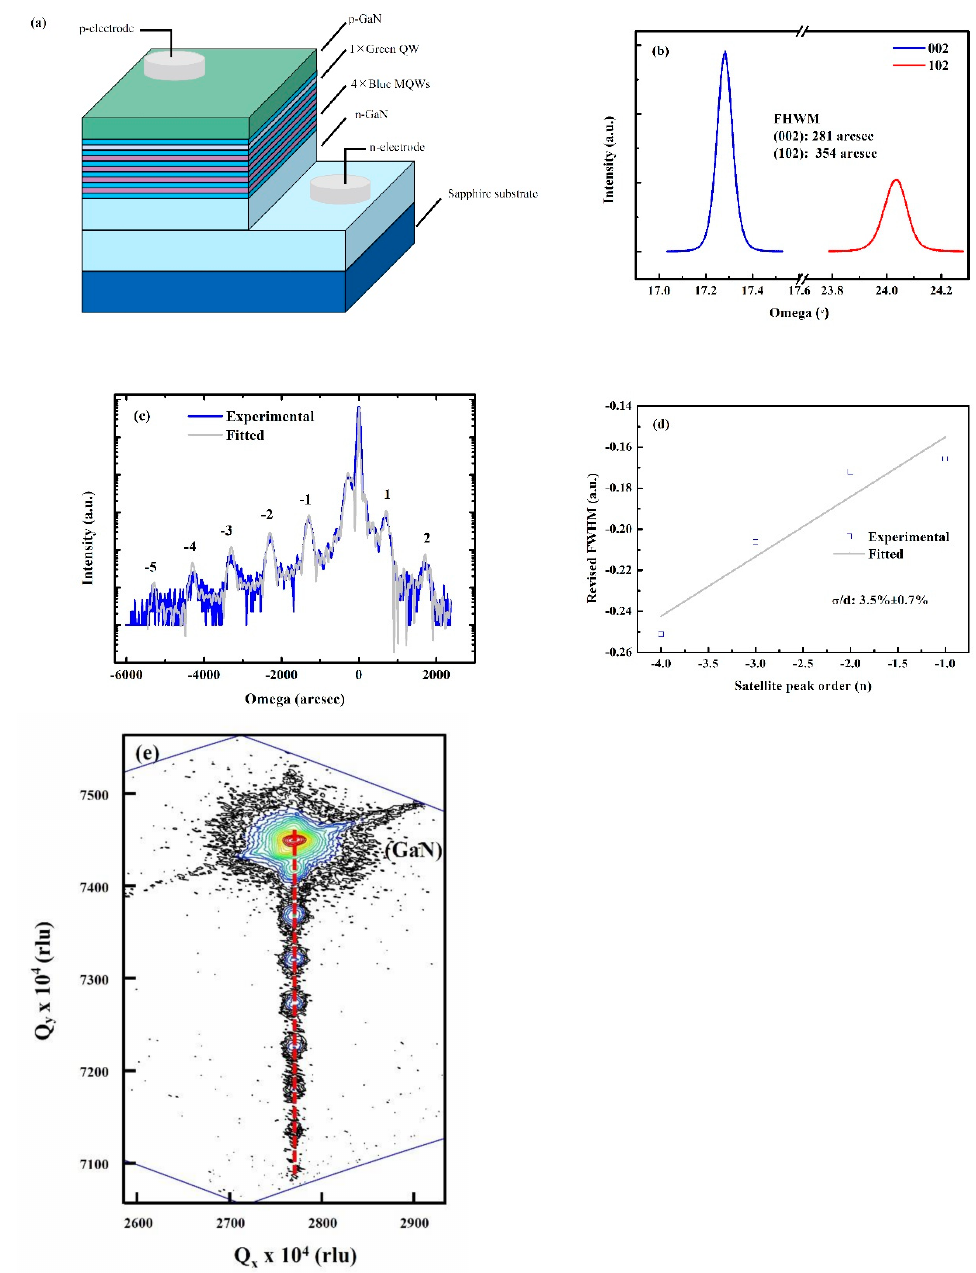
Figure 1. ( a ) The schematic illustration of LED structure. ( b ) The rocking curves of GaN (002) and (102) plane. ( c ) The ω -2 θ curve and the fitted line. ( d ) The revised FWHM of the satellite peaks. The light grey line is the fitted line. ( e ) The RSM image of the LED. The red dotted line is the guide